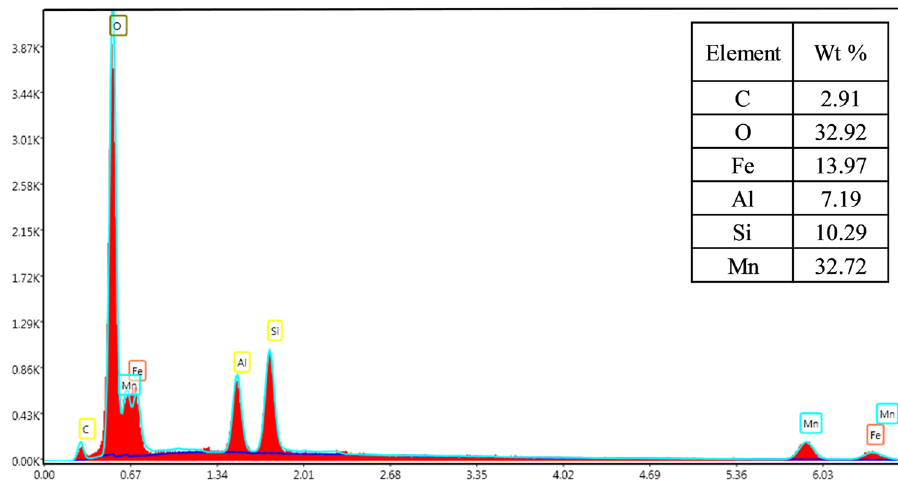
Figure 13: EDS result of the inclusion inside the dimple in the fracture surface of WM in Figure 12 ( f )